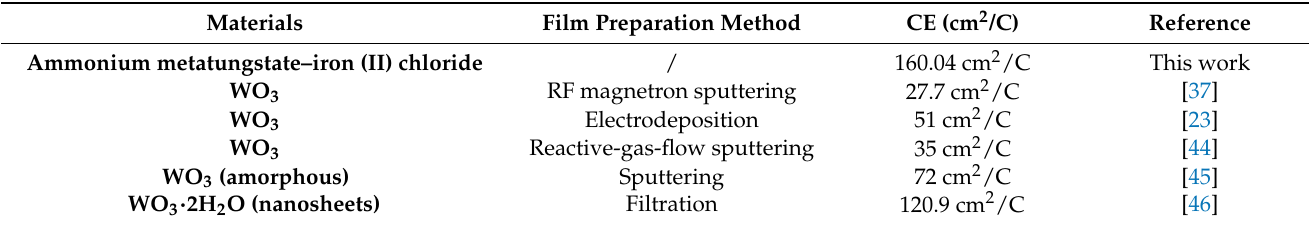
Figure 8. The coloring efficiency diagram at 700 nm for ammonium metatungstate concentration of 0.175 mol/L and iron (II) chloride concentration of 0.20 mol/L at a current density of 5 A/m 2 : scatter plot of coloring efficiency. Table 4. Comparison of electrochromic (EC) materials, film preparation methods, and coloring efficiency (CE) between the literature and this work.